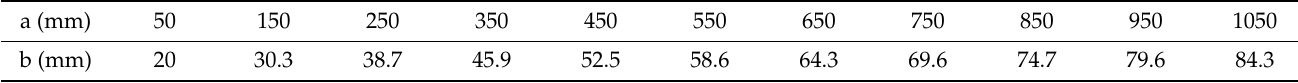
Figure 3. Schematic diagram of a grid plate with unequal spacing (unit: mm).